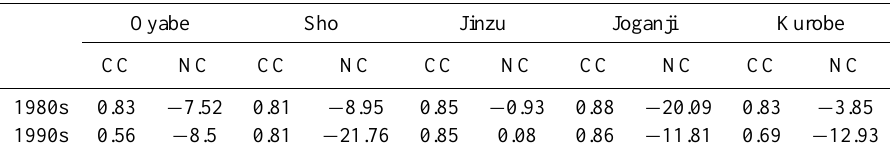
Table 4. Correlation coefficients (CC) and Nash-Sutcliffe efficiency coefficients (NC) of 10-year average monthly mean discharges for the five rivers in the 1980s and 1990s. Oyabe